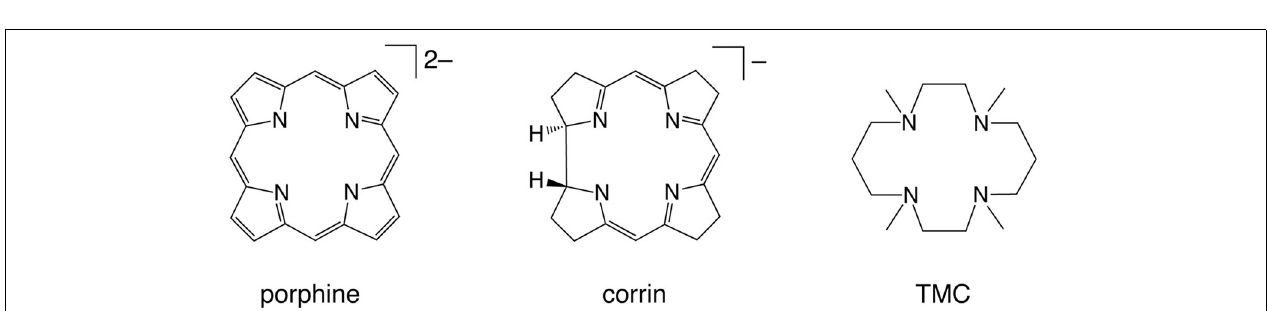
SCHEME 4 | The three ligands studied by Myradalyyev et al. Reprinted from Myradalyyev et al. (2013) with permission from Elsevier.